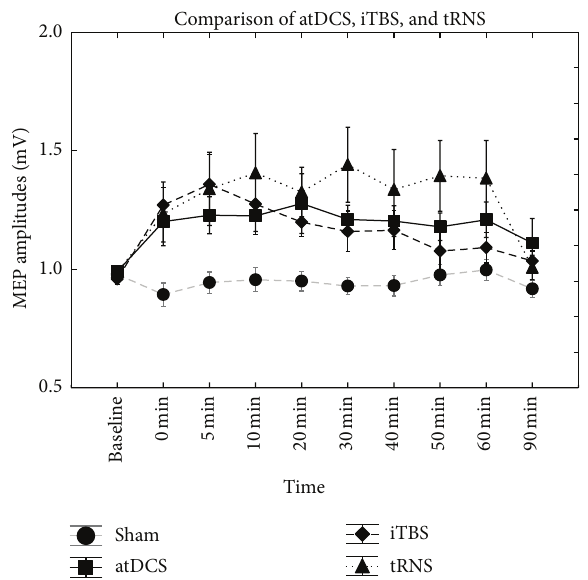
Figure 2: Comparing all of the active stimulation conditions, there were no significant main effects of